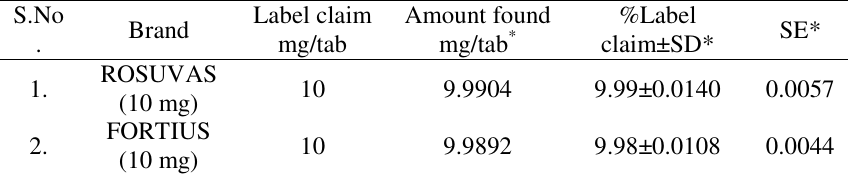
Table 2. Statistical analysis of ROSU